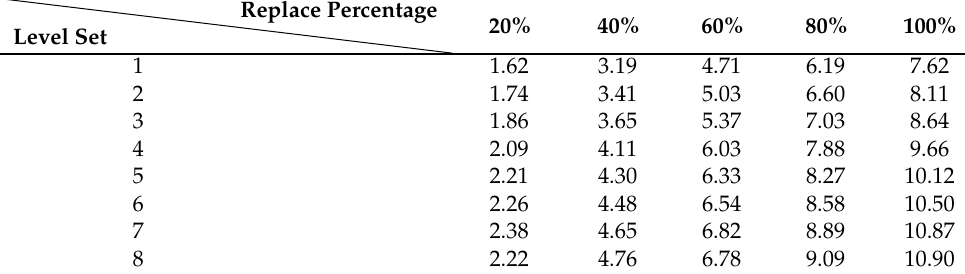
Table 9. Pressure error of substituting the 2nd stage.